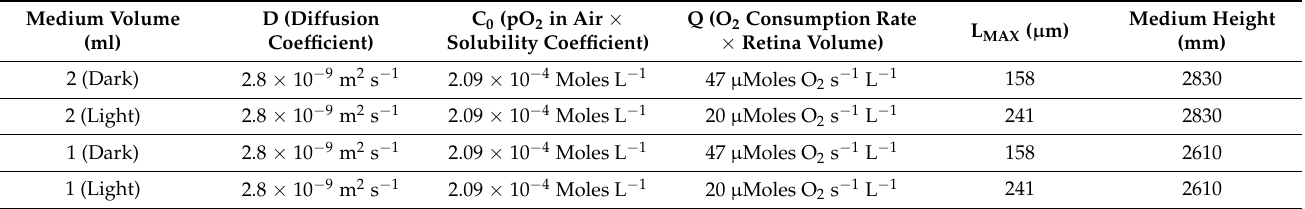
Table 3. O 2 diffusion coefficient (D) is assumed similar in medium and water (2.8 × 10 − 9 m 2 s − 1 ). C 0 , the air/medium interface at 37 ◦ C (2.09 × 10 − 4 Moles L − 1 ), converted in Moles L − 1 from tabulated values in mg/mL (http://www.fao.org/ 3/ac183e/ac183e04.htm, accessed on 15 February 2021) at 37 ◦ C. Q for the mouse retina was computed assuming a retinal volume of 10 µ L and a retinal weight of 9 mg to account for the high lipid content of the OS. The retinal weight is about three times the values reported in Figure S3 of Cerani et al., 2013 [279], but consumption for unit retinal volume is similar. Medium Volume